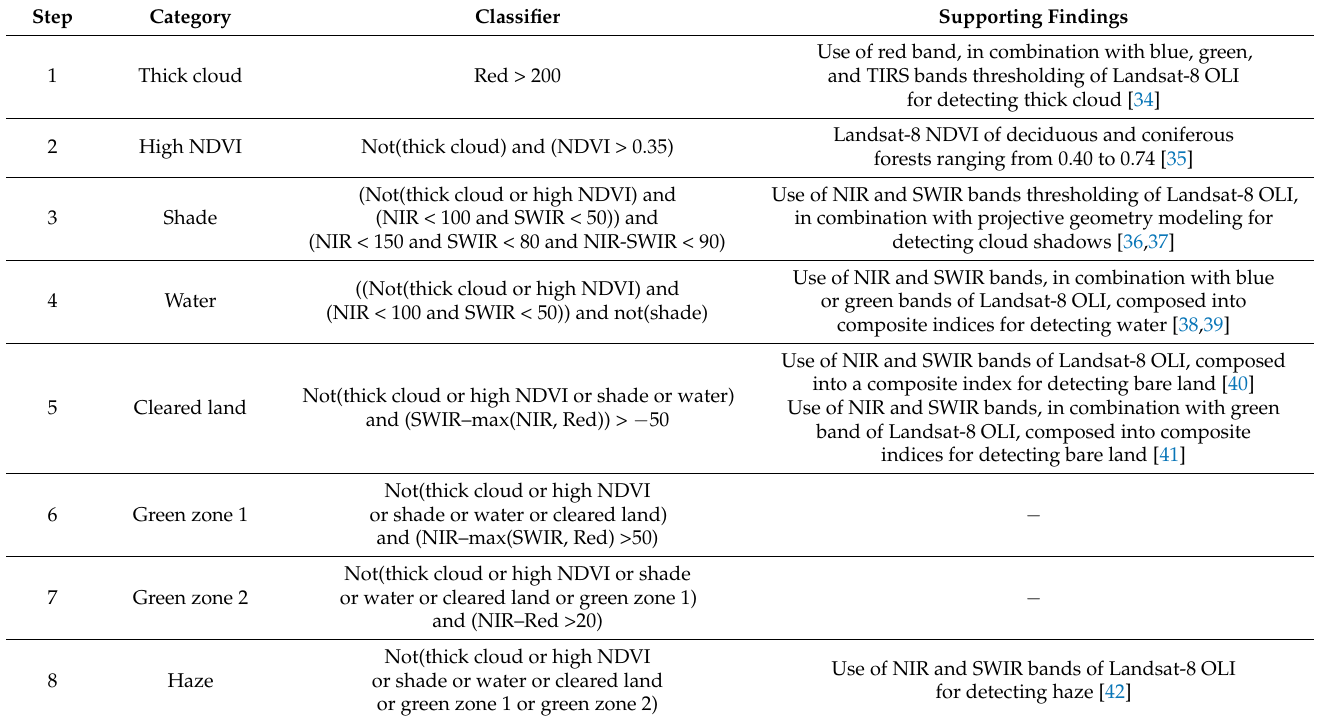
Table A1. Knowledge-based tree-classifier algorithm used in deforestation detection derived from Landsat-8 OLI. Step Category Classifier Supporting